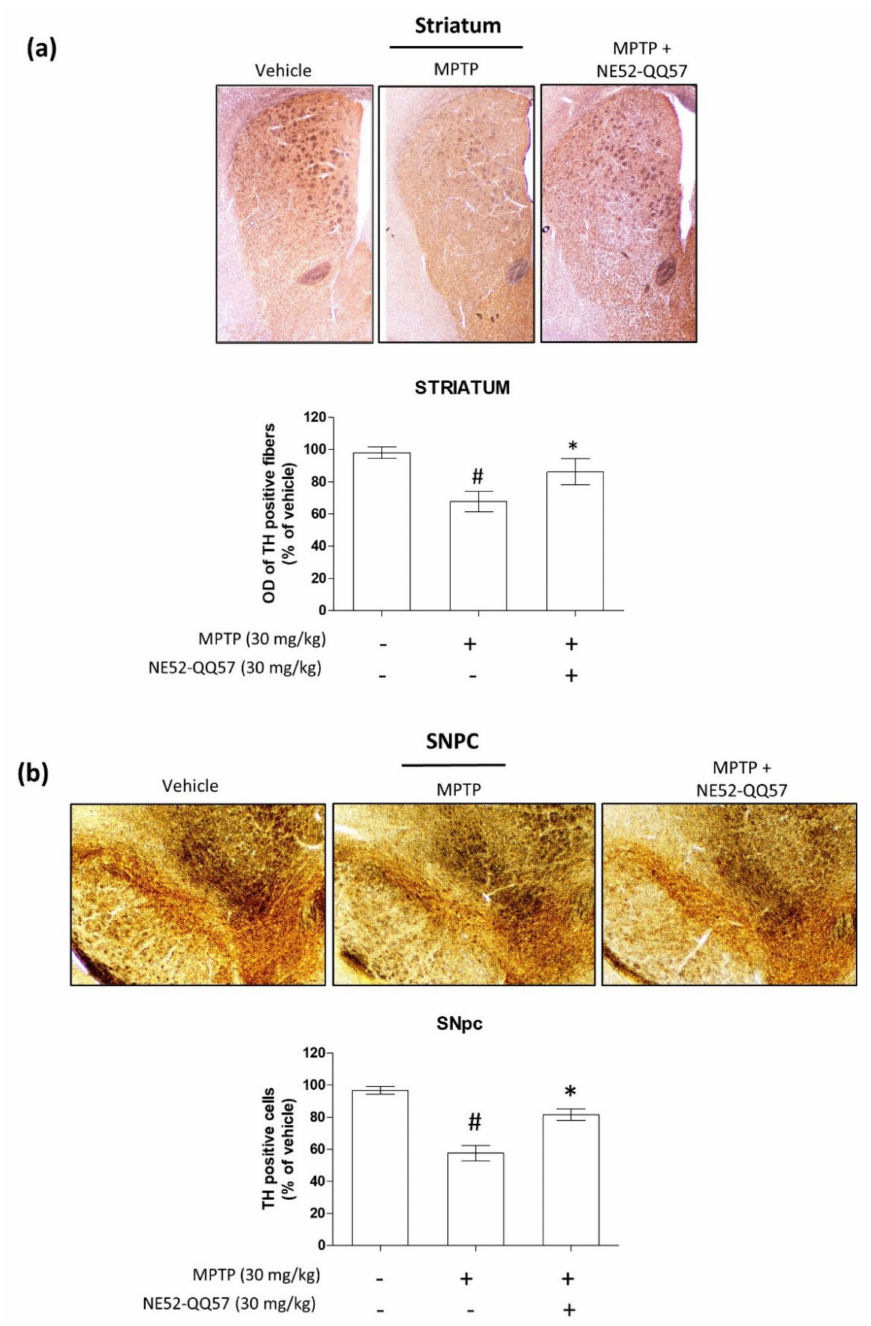
Figure 5. GPR4 inhibition attenuates the depletion of TH-positive cells in the striatum and SNpc of a subchronic MPTP-treated mouse model of PD. MPTP was administered (30 mg/kg/day) for 5 days. After performing behavioral experiments, the mice were anaesthetized for the immunohistochemical study three days after the final MPTP administration. Mice were sacrificed, and the whole brain was isolated to collect sections from the SNpc and striatum regions. ( a ). Representative images of TH-positive fibers immunoreactivity (IR) in sections of the striatum, with densitometric analysis of optical density of TH positive fibers ( n = 3–4). ( b ). Representative images of TH-positive cell IR in the SNpc sections, with densitometric analysis for TH positive cells ( n = 3–4). Data are presented as mean ± SEM. One-way ANOVA, followed by Tukey’s multiple comparison test, was used to determine significant differences between groups. # p < 0.05 when the MPTP-treated group was compared with the vehicle-only group; * p < 0.05 when the other treated groups were compared with the MPTP-treated